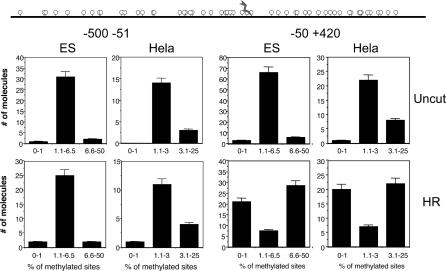
Distribution of Methylated CpGs before and after DSB Repair by Homologous RecombinationStatistical analysis of CpG methylation following a DSB is shown. Cassette I was arbitrarily divided in two segments located at −500 to −51 and −50 to + 420 bp relative to the I-SceI site. Methylation was measured as percent of methylated CpGs in each molecule relative to all CpGs present in the segment. GFP molecules were arbitrarily divided in three classes: unmethylated (0%–1% methylated sites), methylated (1.1%–6.5% in ES and 1.1%–3% in Hela), and hypermethylated 6.5%–50% and 3.1%–25% in Hela). The methylated class contains all molecules between ±1 standard deviation. After DSB and homologous recombination, the normal (Gaussian) distribution of methylated sites change to a bimodal distribution in both cell lines in the segment downstream to the break (p < 0.001 Shapiro-Wilk test, JMP statistical analysis software, http://www.jmp.com).